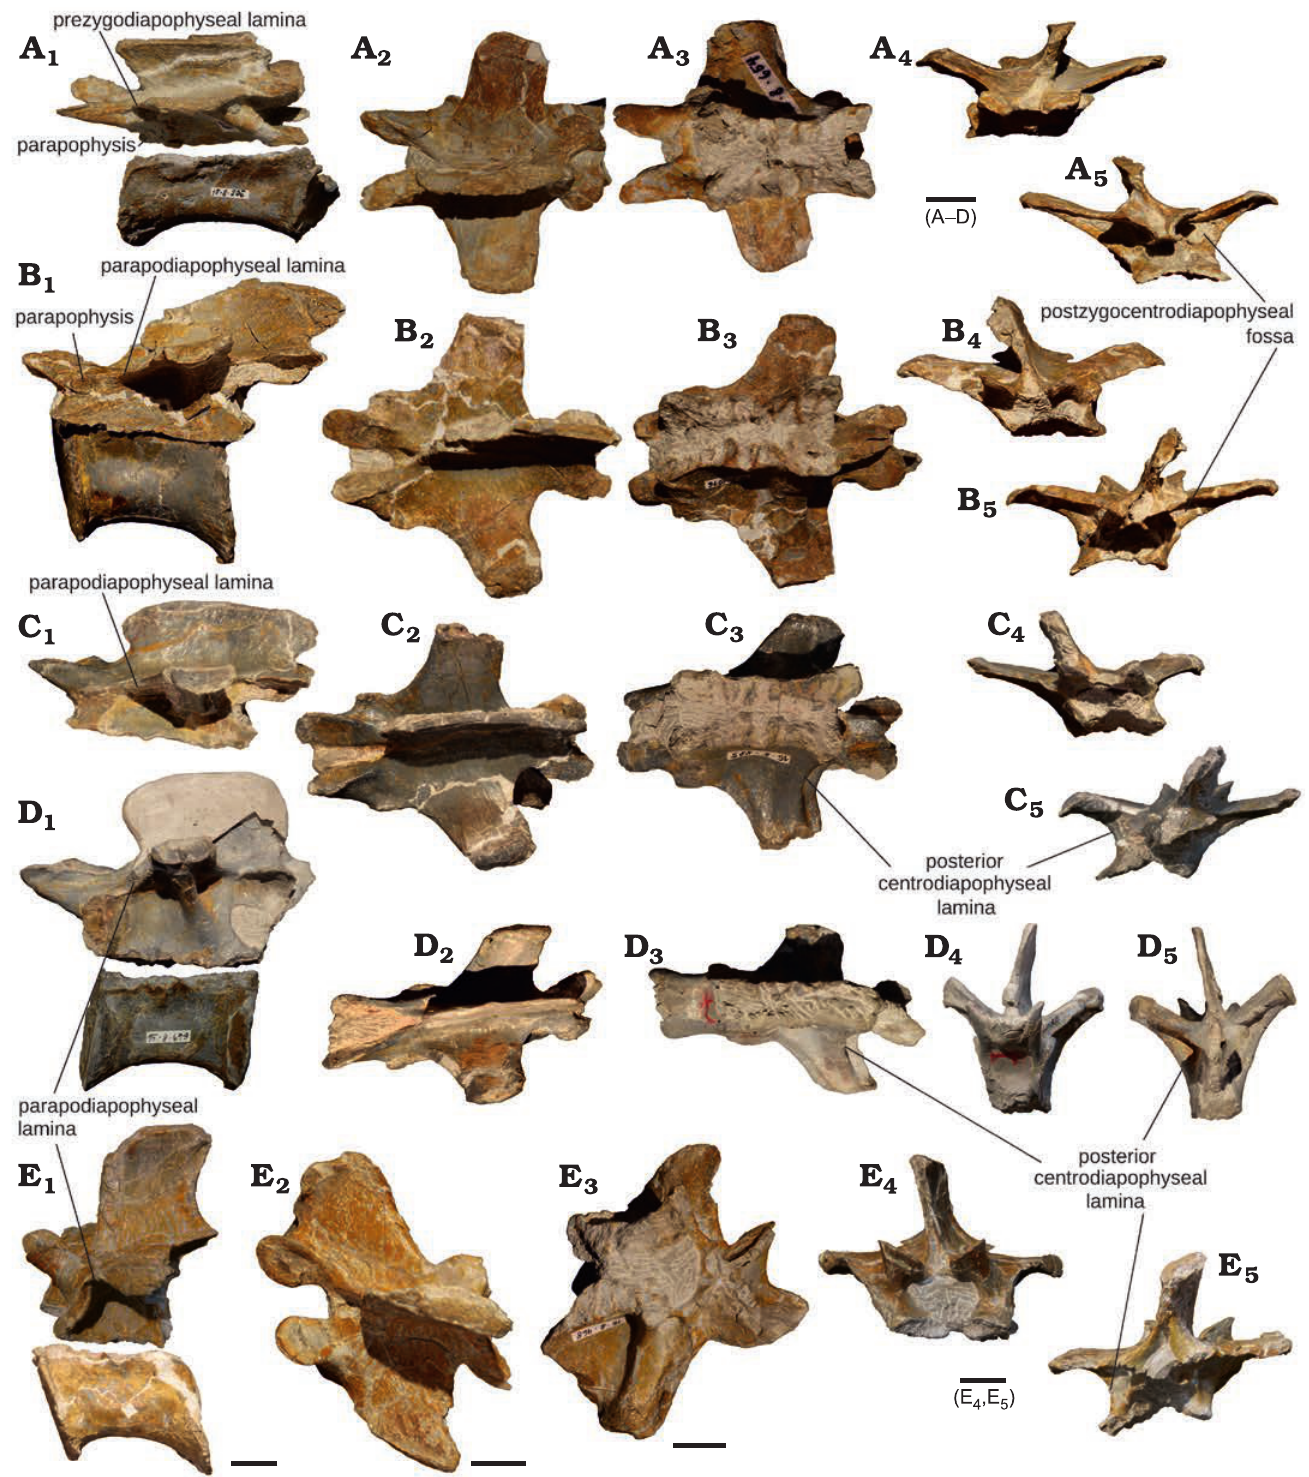
Fig. 4. Middle and posterior dorsal vertebrae of juvenile Plateosaurus cf. trossingensis Fraas, 1913 skeleton MSF 15.8B. from the Norian of Frick, Switzerland. A . Dorsal vertebra 6, MSF 15.8.654 (neural arch) and MSF 15.8.906 (centrum), in left lateral (A 1 ), dorsal (A 2 ), ventral (A 3 ), anterior (A 4 ), and posterior (A 5 ) views. B . Dorsal vertebra 7, MSF 15.8.1076 (neural arch) and MSF 15.8.437 (centrum), in left lateral (B 1 ), dorsal (B 2 ), ventral (B 3 ), anterior (B 4 ), and posterior (B 5 ) views. C . Dorsal vertebra 8, MSF 15.8.885, in left lateral (C 1 ), dorsal (C 2 ), ventral (C 3 ), anterior (C 4 ), and posterior (C 5 ) views. D . Dorsal vertebrae 9 or 10, MSF 15.8.728 (neural arch) and MSF 15.8.679 (centrum), in left lateral (D 1 ), dorsal (D 2 ), ventral (D 3 ), anterior (D 4 ), and posterior (D 5 ) views. E . Dorsal vertebra 12, MSF 15.8.468 (neural arch) and MSF 15.8.2007 (centrum), in left lateral (E 1 ), dorsal (E 2 ), ventral (E 3 ), anterior (E 4 ), and posterior (E 5 ) views. Scale bars 10